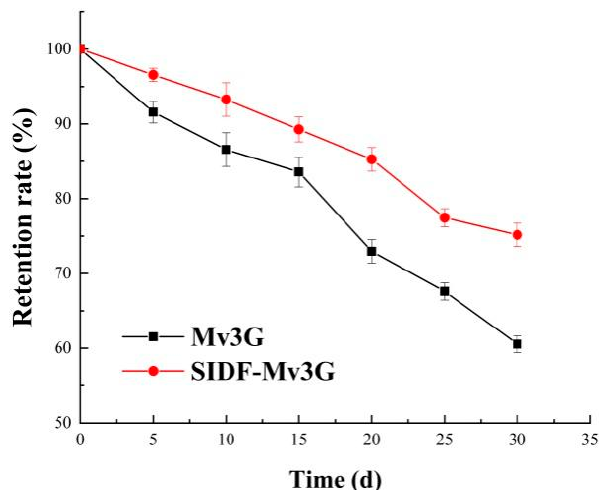
Figure 3. Retention rate of sunlight treatment at room temperature. SIDF-Mv3G: the stability system solution of soybean insoluble dietary fiber and malvidin-3- O -glucoside; Mv3G: malvidin-3- O -glucoside solution.